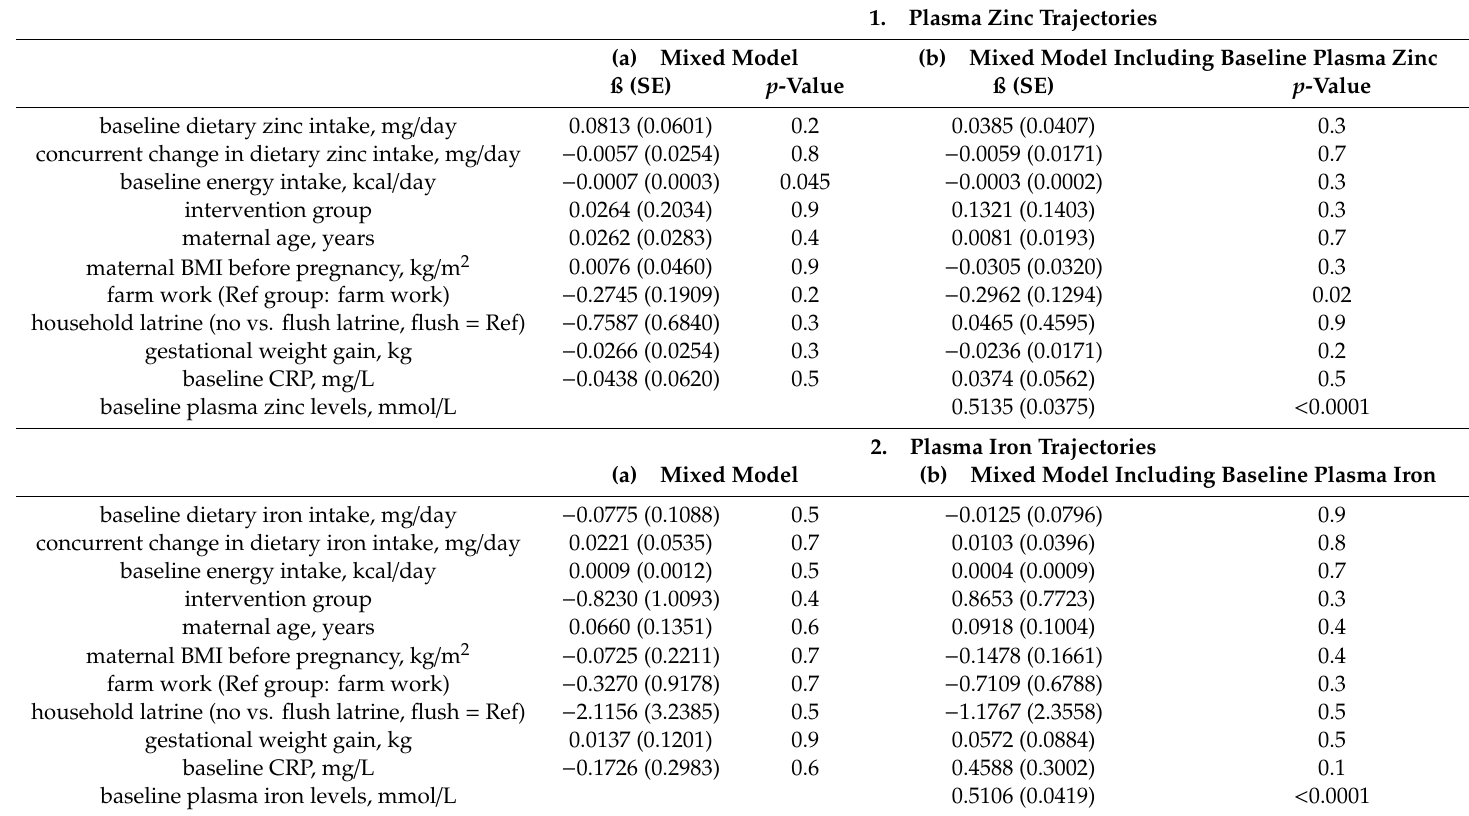
Table 3. Mixed models of biomarker trajectories over the course of pregnancy ( n = 317). 1. Plasma Zinc